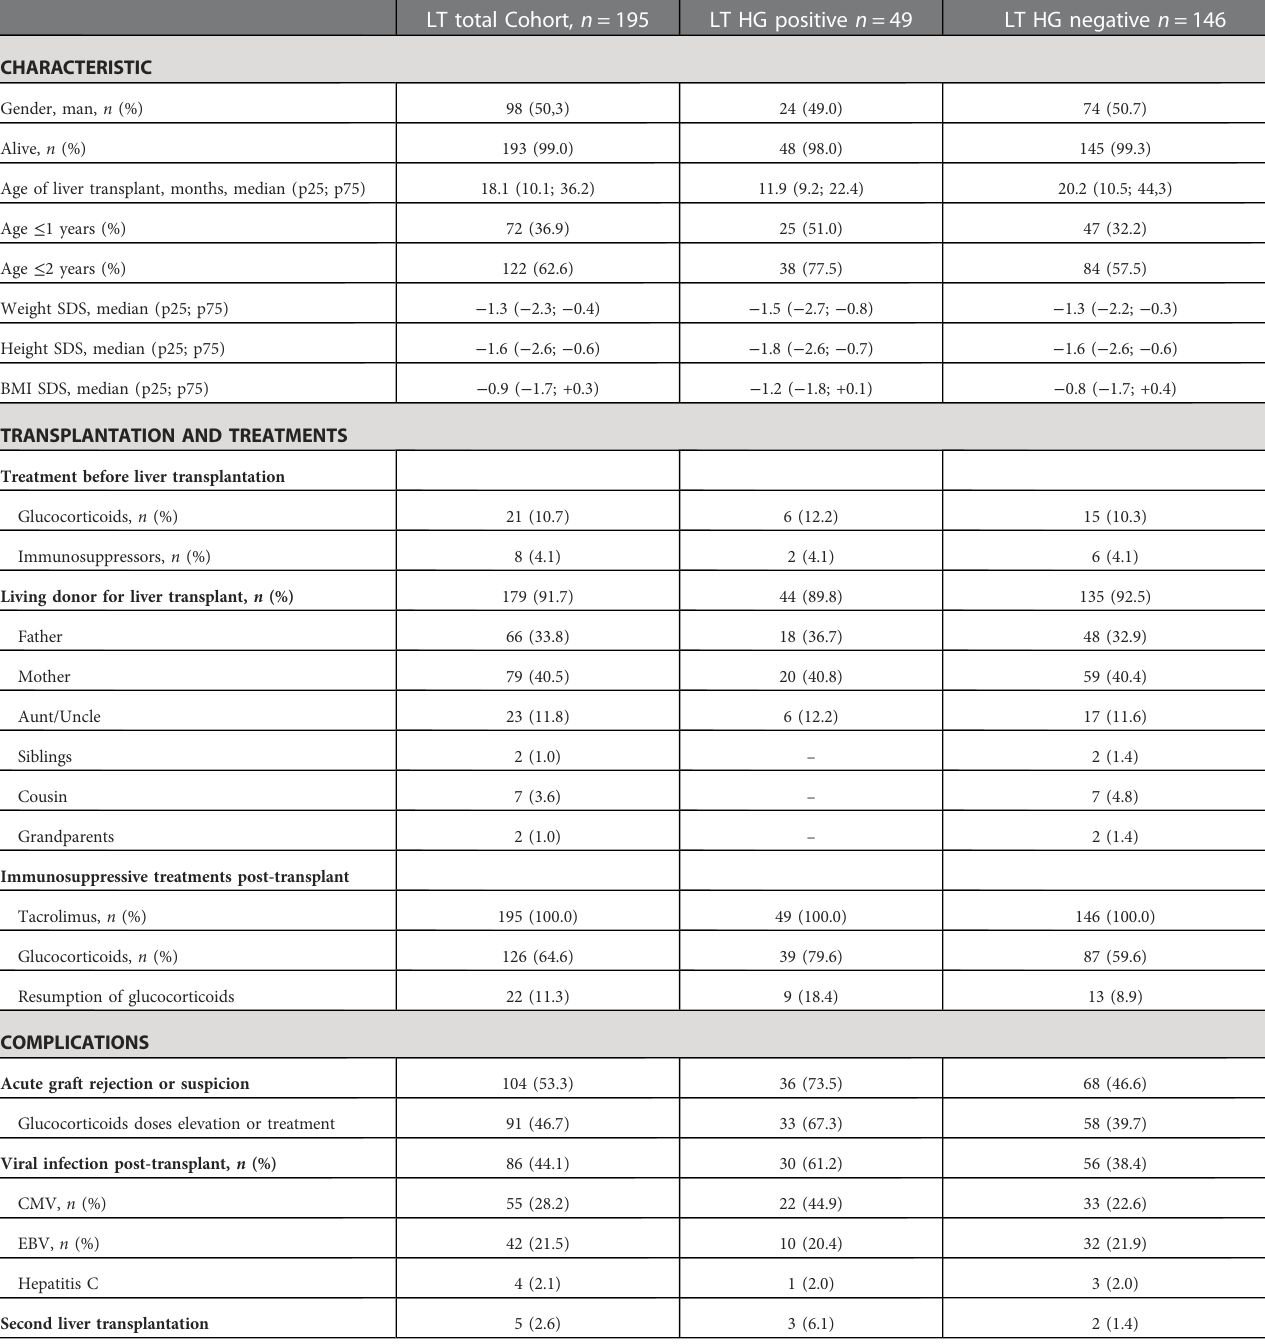
TABLE 1 Characteristic and treatment of pediatric liver transplant patients